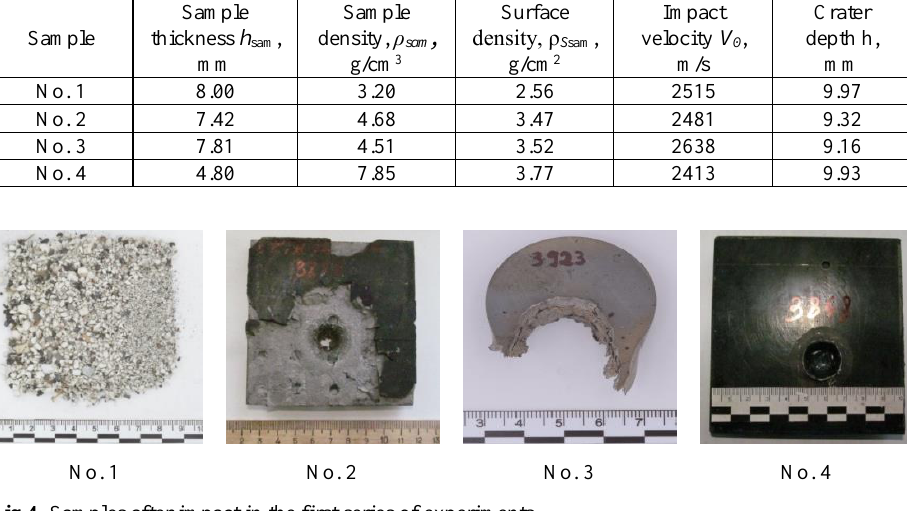
Fig 4. Samples after impact in the first series of experiments